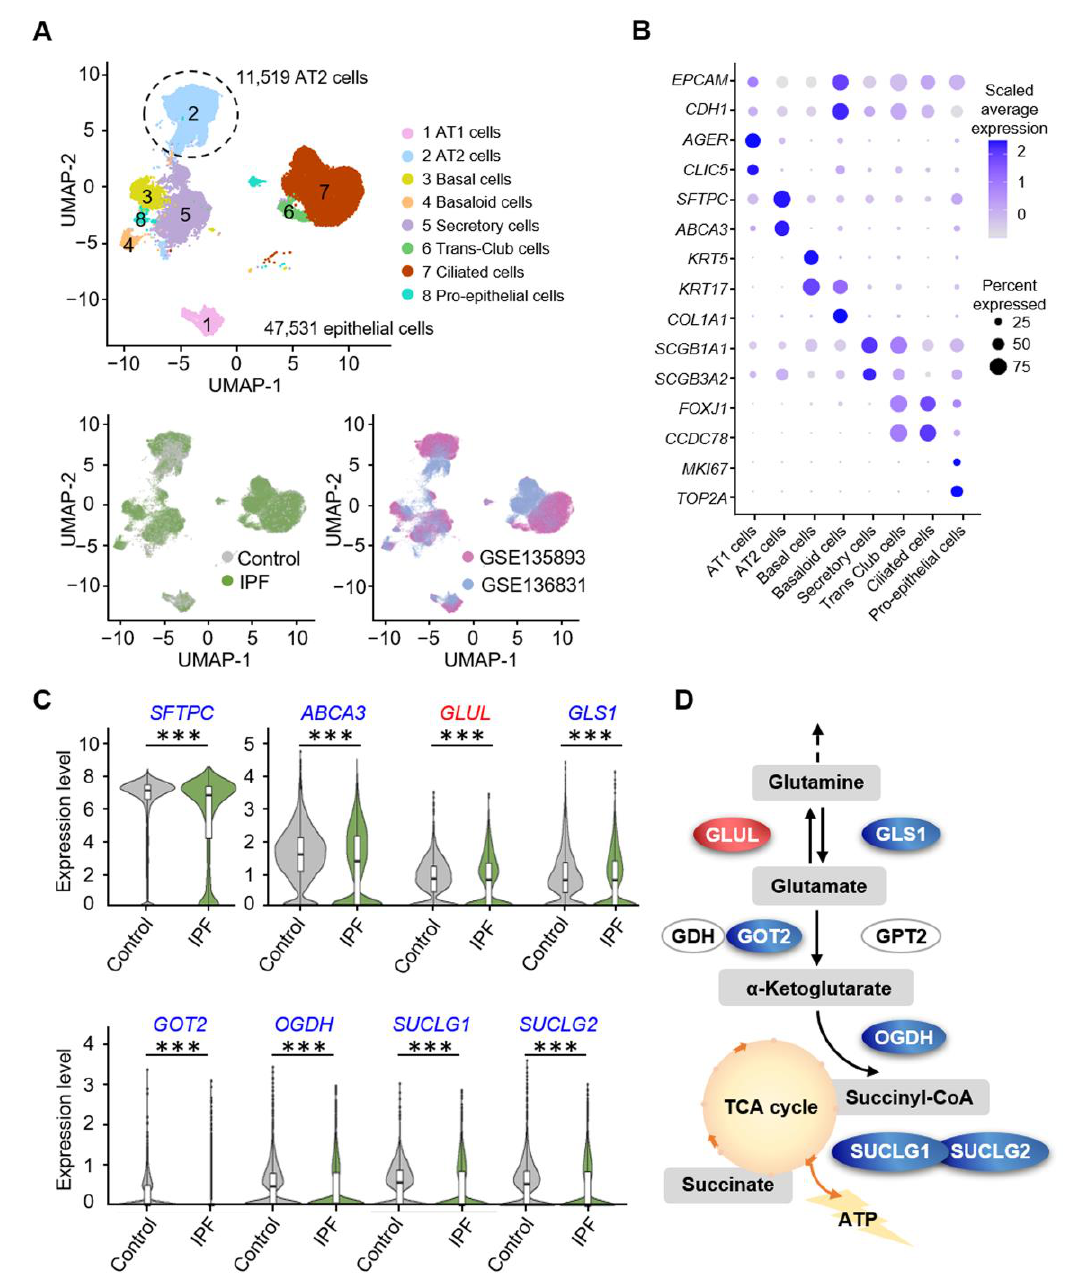
Figure 1. Glutamine metabolism is downregulated in AT2 cells of patients with IPF. ( A ) Uniform Manifold Approximation and Projection (UMAP) graphical representation of 47,531 epithelial cells from 44 IPF and 38 control lungs (top), disease status (bottom left), and subjects (bottom right). Each dot represents a single cell and cells are labeled as one of eight discrete cell varieties, with AT2 cells labeled by the number 2. ( B ) Dotplot of the canonical marker gene expression in eight epithelial cell types. Node size is proportional to the percentage of cells in the cluster expressing a gene. Node color is proportional to the average expression level of the gene in the cluster. ( C ) Violin plots show gene expression in AT2 cells from the samples in 1A, and the upregulated (red) gene GLUL and the downregulated (blue) genes SFTPC , ABCA3 , GLS1 , GOT2 , OGDH , SUCLG1 , and SUCLG2 are depicted. ( D ) Glutamine metabolism pathway diagram shows the genetic alterations that regulate the related enzymes, according to the integrated analysis of scRNA-seq data from healthy donors or patients with IPF. Upregulated and downregulated genes are marked in red and blue, respectively. *** p < 0.001.